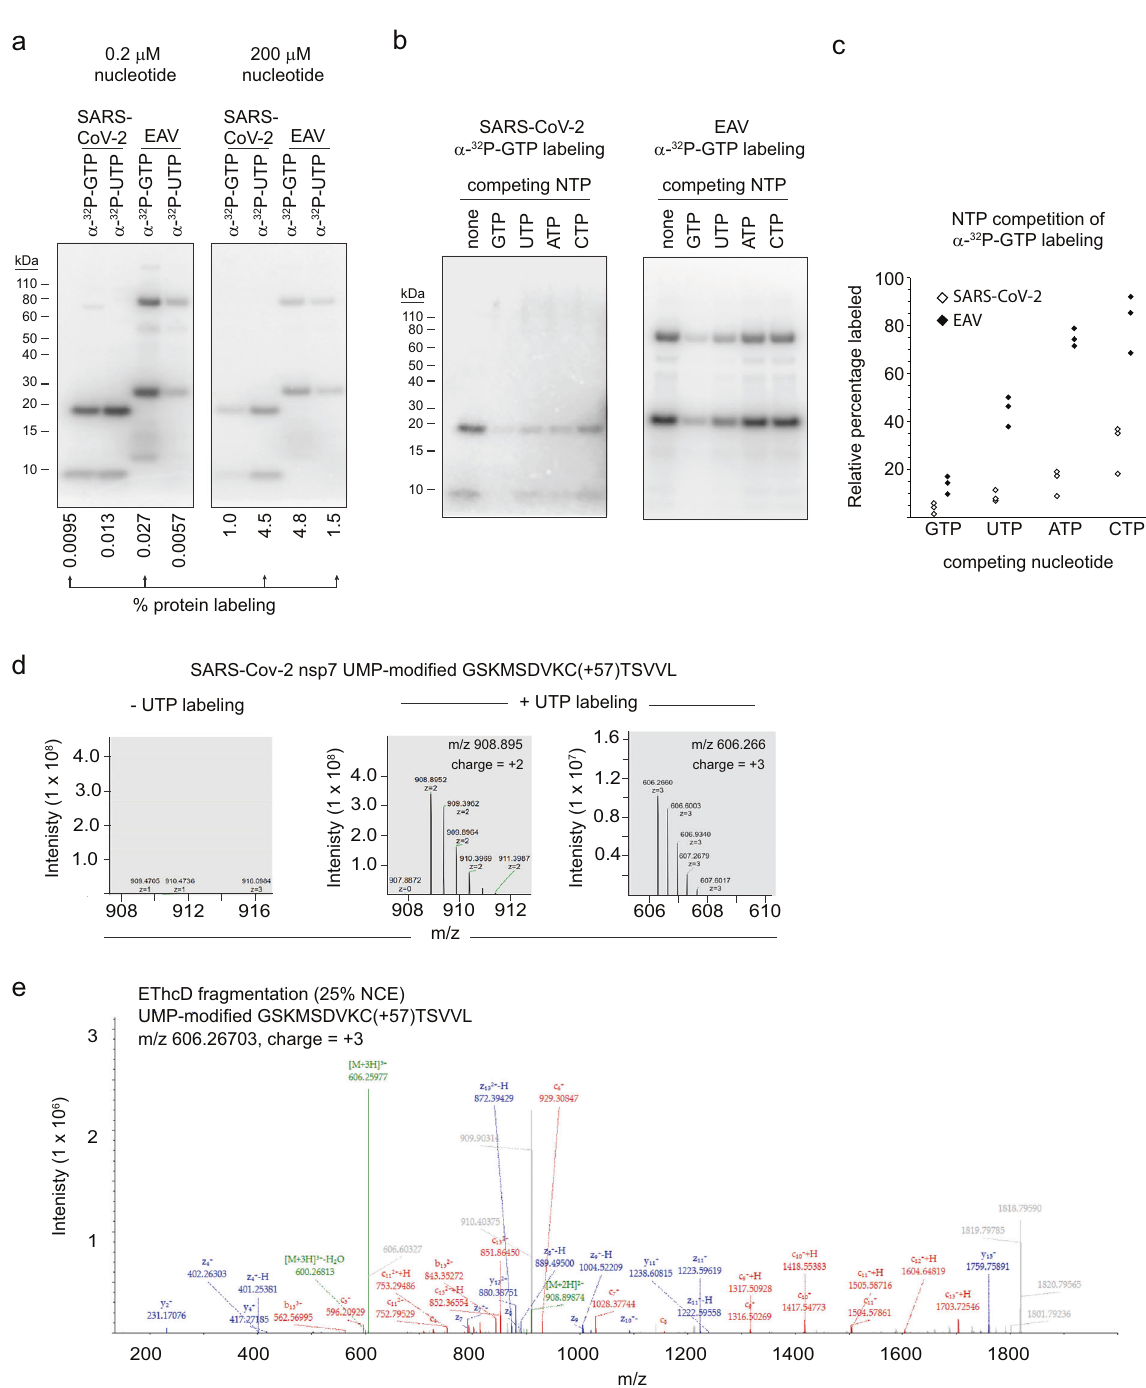
Fig. 5 SARS-CoV-2 and EAV radiolabeling with UMP. a Radiolabeling of SARS-CoV-2 (nsp7 and nsp8) or EAV (nsp7 and nsp9) proteins using either α - 32 P-GTP or α - 32 P-UTP at a total nucleotide concentration of ~0.2 μ M or 200 μ M. The total percentage of nsp proteins labeled in each experiment is shown below autoradiographs, given 0.6 – 2.7 μ M of each labeled protein per reaction. Identical exposures are shown for left and right panels. Results represent a single experiment. b Competition of α - 32 P-GTP labeling (at 10 μ M) with 316 μ M of the indicated cold nucleotide. Autoradiographs are shown of an SDS-PAGE protein analysis. c The percentage 32 P-GMP labeling remaining after direct competition with 316 μ M GTP, UTP, ATP or CTP. Three separate experiments ( n = 3) were performed for both SARS-CoV-2 (white diamonds) and EAV (black diamonds), and individual data points are shown. d LC – MS spectra at 39.7 min for SARS-CoV-2 samples that were labeled with UTP or not. Spectra show peaks at m/z of ~908.897 and 606.267, which correspond the SARS-CoV-2 nsp7 1 – 14 peptide (GSKMSDVKCTSVVL) in charge states of + 2 and + 3, respectively, that has been modi fi ed with UMP (306.0253 amu mass addition). e Top peptide spectrum match for UMP-labeled GSKMSDVKCTSVVL peptide that was derived from chymotrypsin-digested SARS-CoV-2 nsp7 protein. EThcD fragmentation of the 606.266 peptide ion was used with 25% normalized supplemental collisional energy (NCE). Detection of the UMP-modi fi ed peptide was observed in a single experiment with two technical